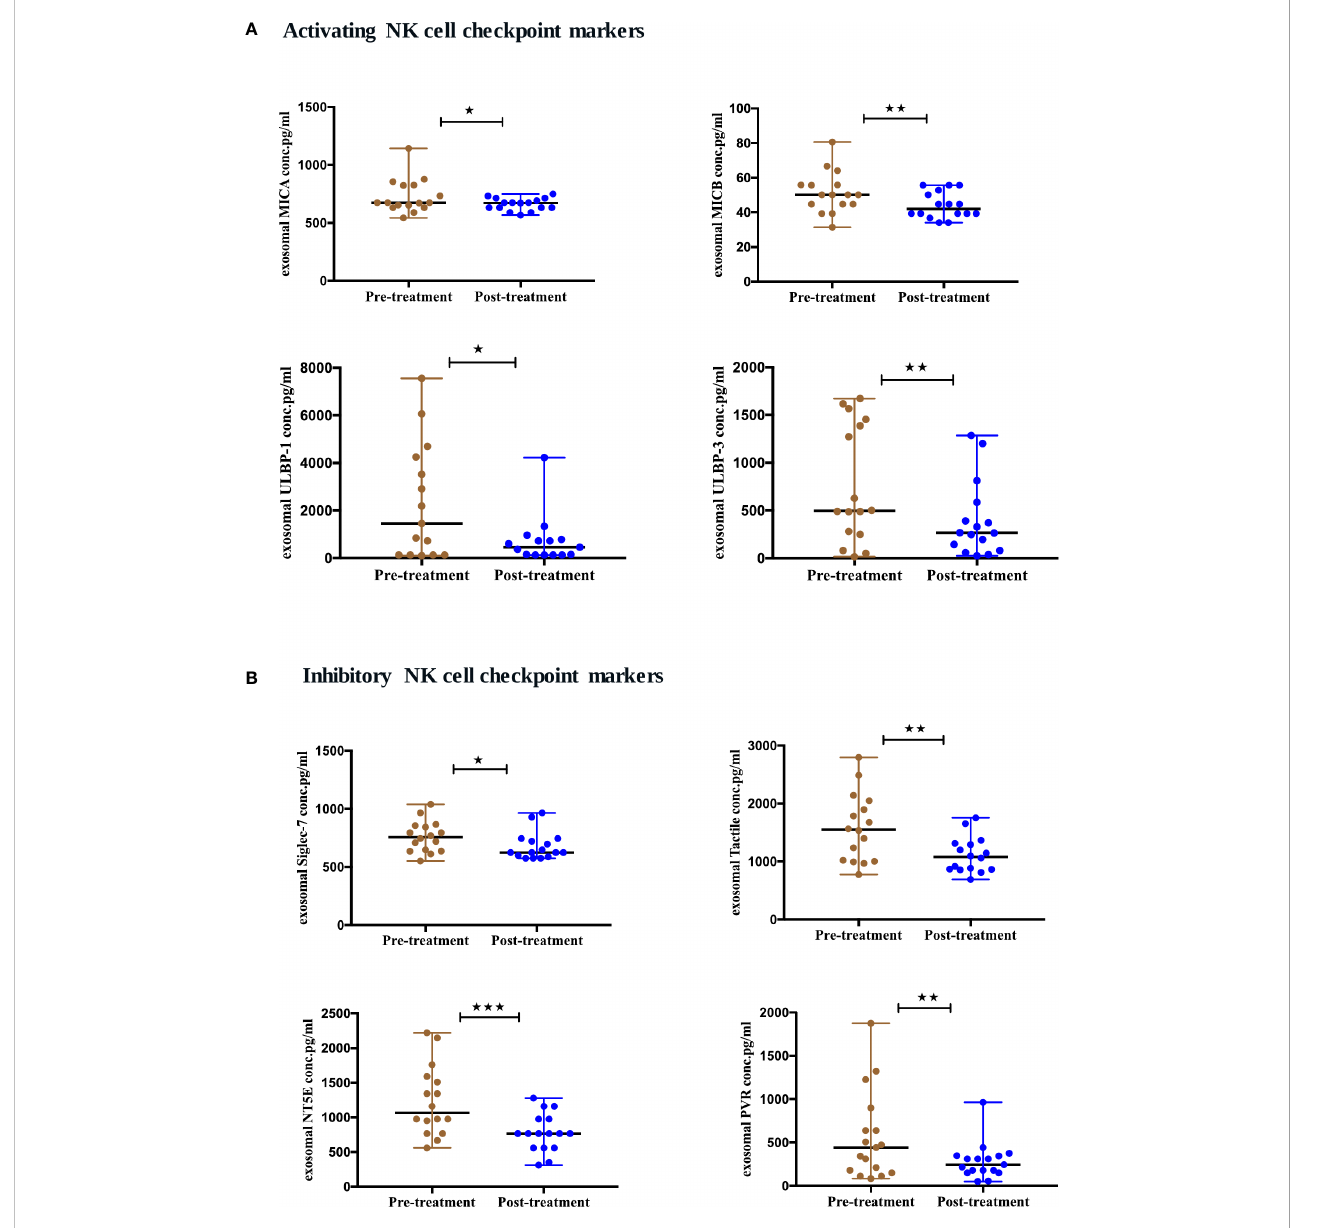
FIGURE 6 Differential expression of exosomal NK cell checkpoint markers post-ICI therapy. (A) Activating NK cell checkpoint markers (B) Inhibitory NK cell checkpoint markers from serum-derived exosomes of NSCLC patients (n=17) before and after anti-PD-1/PD-L1 therapy. Two-tailed Wilcoxon matched- pairs signed rank test (*p<0.05, **p<0.01,